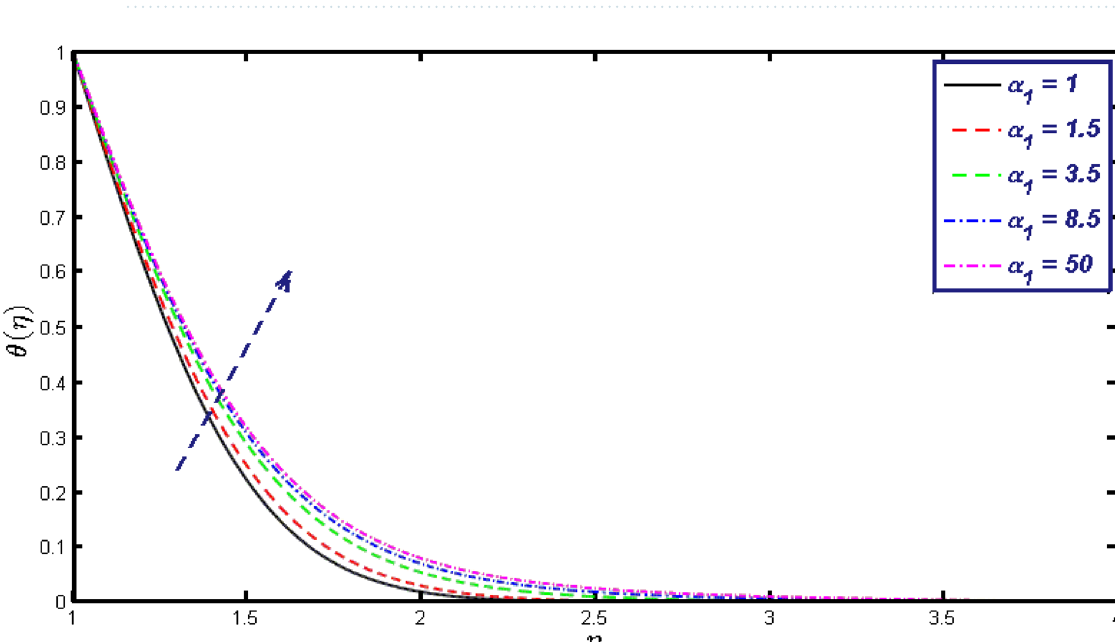
Figure 7. Velocity field for different values of ε .